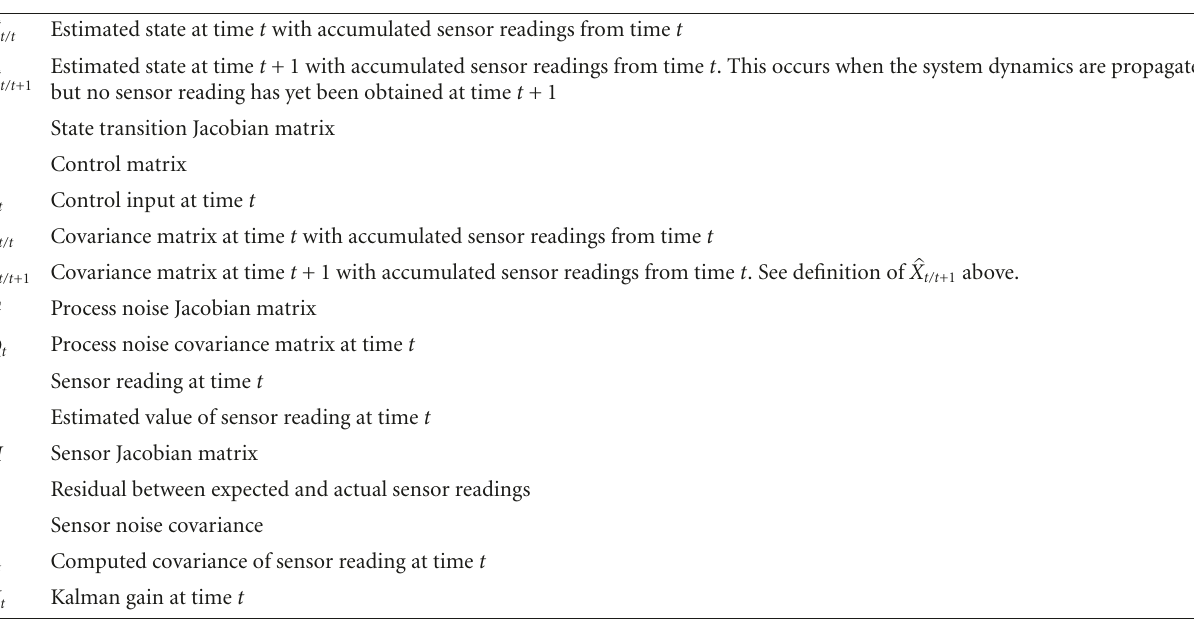
Table 6: Description of terms used in the multiple hypothesis Kalman filter algorithm.